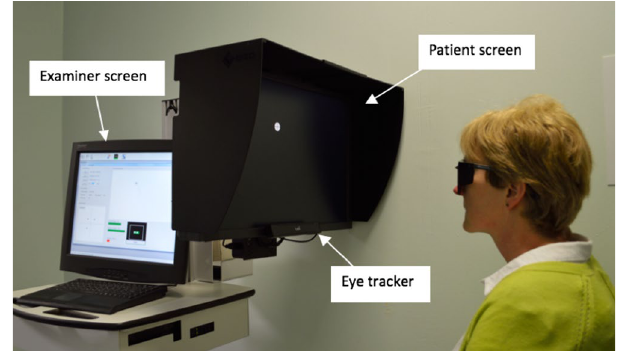
Figure 1. The threshold saccadic vector optokinetic perimetry (SVOP) instrument showing the patient screen, eye tracker position and examiner